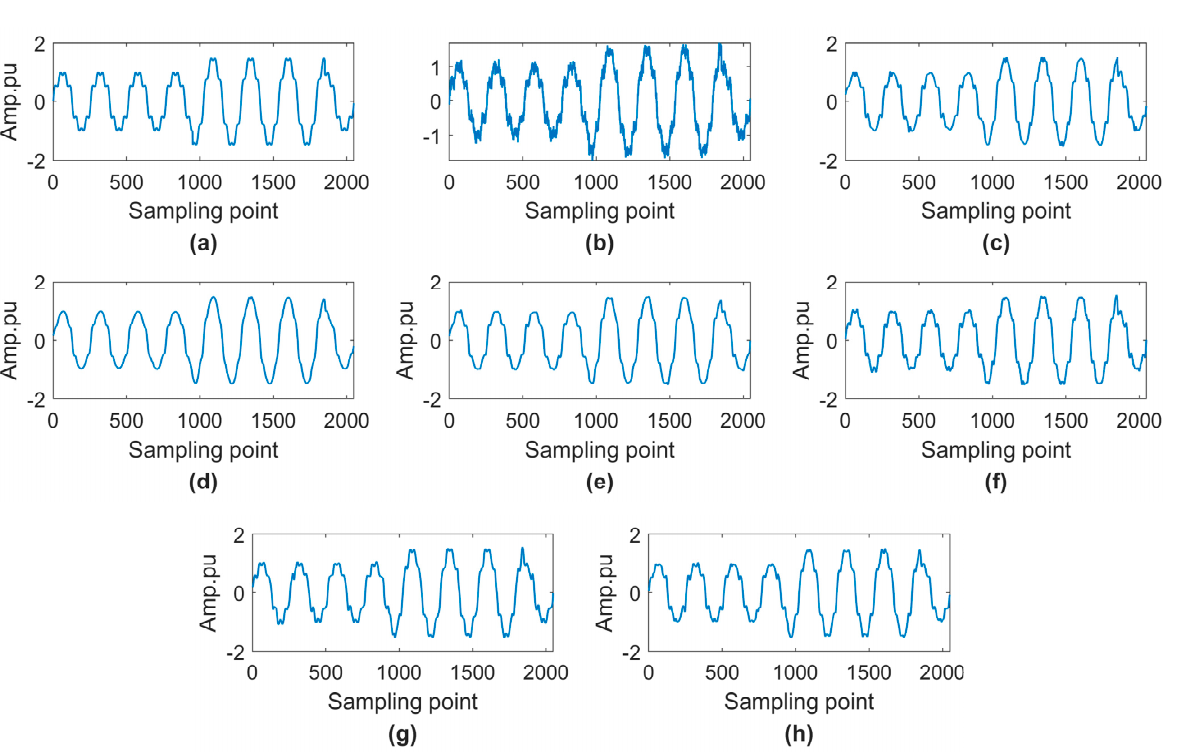
Figure 6. Comparing the denoising impacts of various approaches on an impulsive transient with a 20 dB SNR .